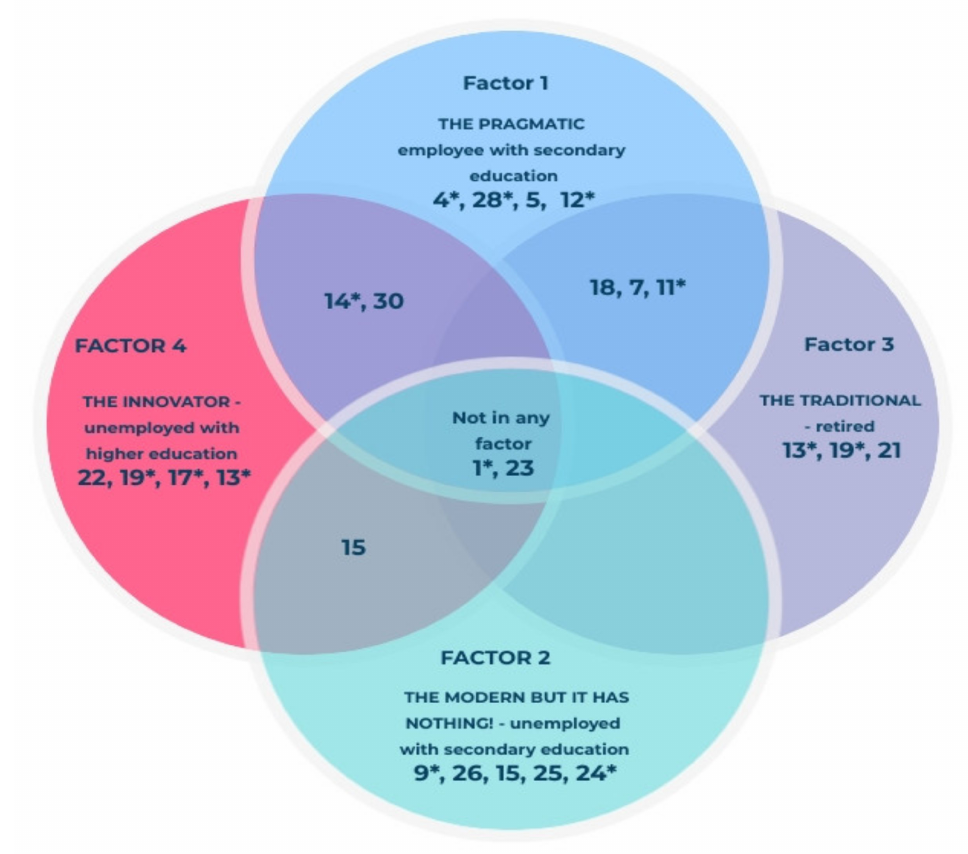
Figure 6. Venn diagram for the agree/disagree statements for each factor. (Note: * p -value < 0.01). The next important step in Q factor analysis is to calculate the z-scores, the factorial scores from gross scores, and weights for each factor. Figure 7 represents the z-scores.